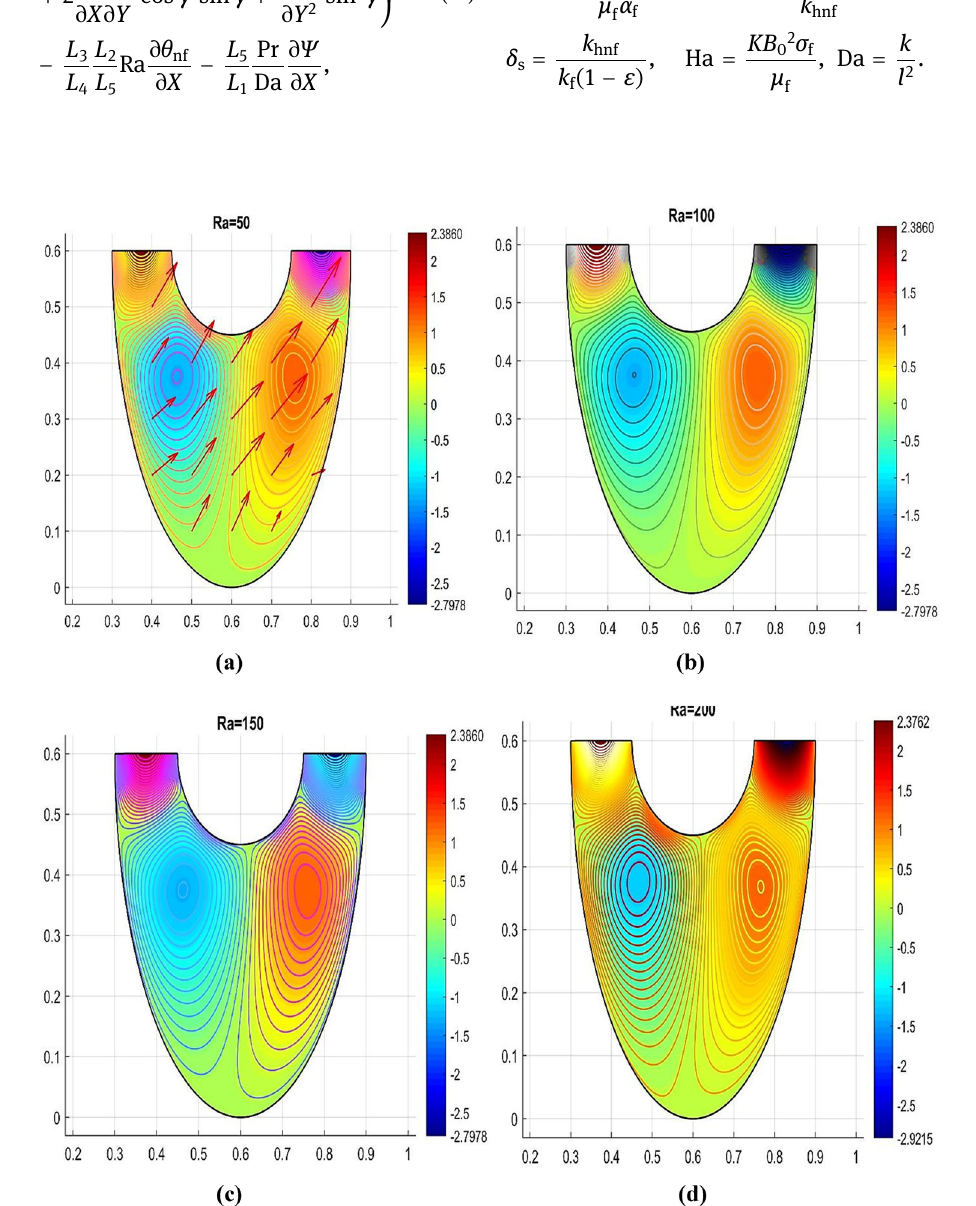
Figure 2: Di ff erent Rayleigh numbers for velocity pro fi